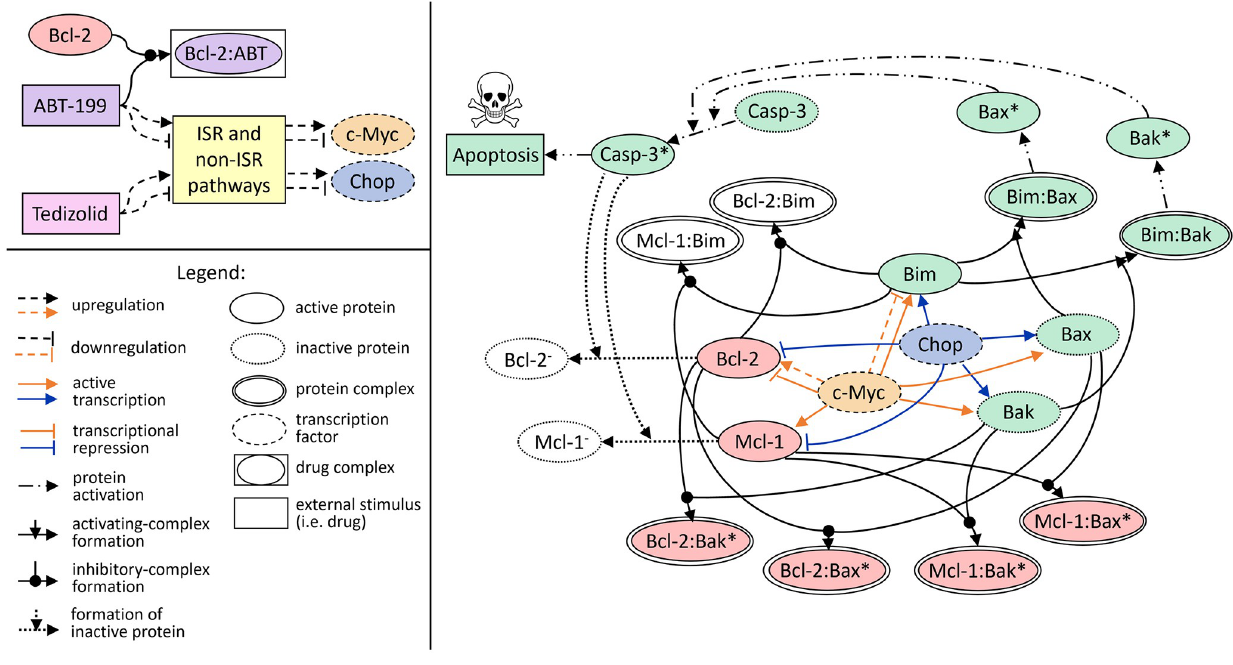
Fig 2. Protein network corresponding to the key interactions between the intrinsic apoptosis pathway and the integrated stress response (ISR). Direct and indirect regulatory effects of venetoclax (ABT-199) and tedizolid on the coupled pathway are shown in the left panel. ABT-199 binds to Bcl-2 to form a protein-drug complex [5, 162]. In addition, both ABT-199 and tedizolid perturb ISR-related and non-ISR pathways, ultimately exerting both positive and negative regulatory effects on c-Myc and Chop (ISR effector protein) expression levels [26, 116]. The coupled apoptosis-ISR pathway is shown in the right panel and depicts the regulatory effects of the transcription factors c-Myc and Chop on the Bcl-2 family proteins, including both the pro-survival and pro- apoptosis effects of c-Myc [128, 130–132, 136–141], as well as the pro-apoptosis effects of Chop [143, 145, 146, 149, 152–157]. In addition, the interactions between the Bcl-2 family proteins [87–89] are shown, including the binding of anti-apoptosis proteins (Bcl-2, Mcl-1) with pro-apoptosis activator (Bim) and effector (Bax, Bak) proteins, as well as the binding of activator and effector proteins and the subsequent activation of the latter. The activated effector proteins cause Caspase-3 activation, which causes cleavage of the anti-apoptosis proteins and promotes apoptosis [80, 85–87, 90–99]. The pro-apoptosis species are coloured green, anti-apoptosis species are red, neutral species are white, c-Myc is orange, and Chop is blue.